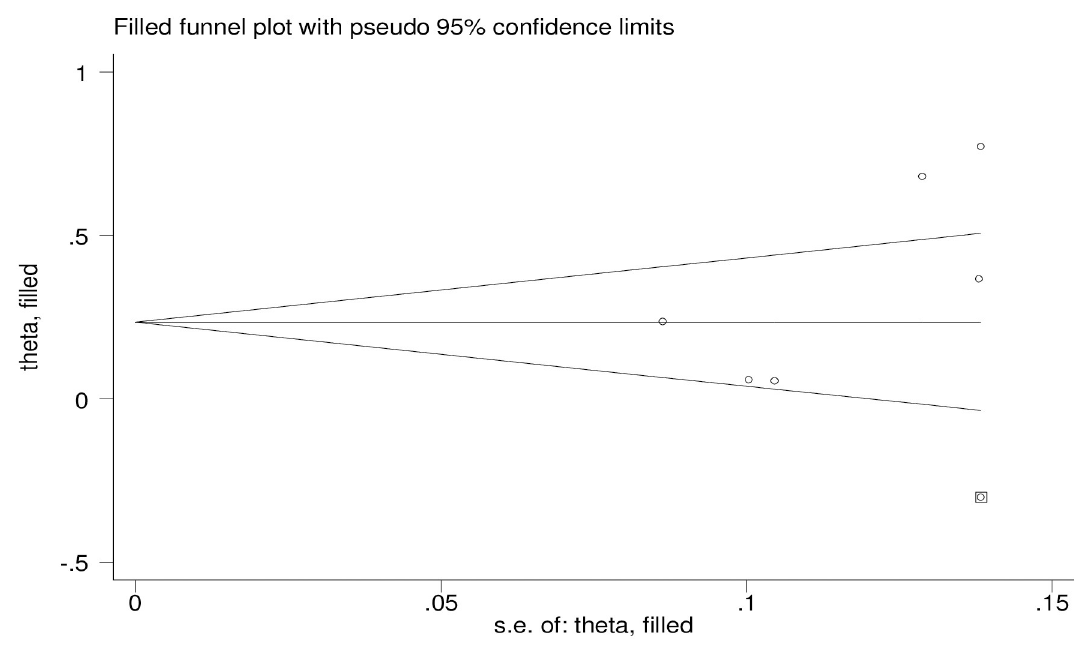
Fig 5. Result of trim and filled analysis for adjusting publication